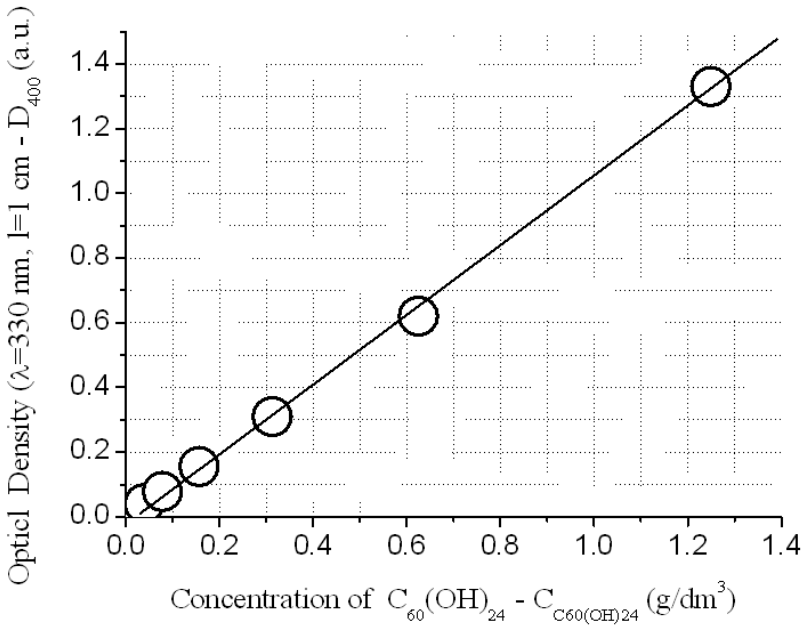
Figure 2. Implementation of the Bouguer-Lambert-Ber law of light absorption of the water solution of C 60 (OH) 24 at λ = 400 nm.